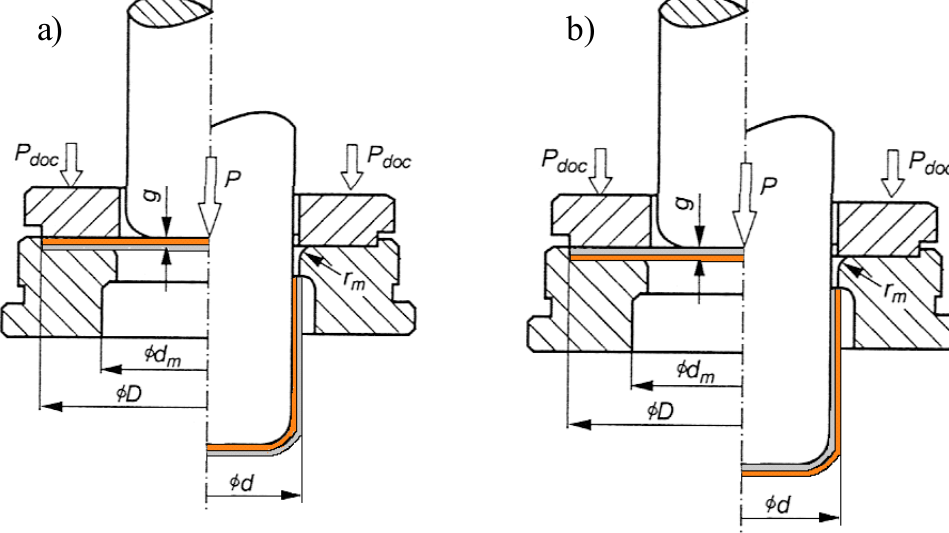
Figure 5. Conditions of the drawing process: ( a ) in the matrix–aluminum system (Al-1050 Cu-M1E), and ( b ) in the matrix–copper system (Cu-M1E Al-1050), left part in Figures before and right after drawing .